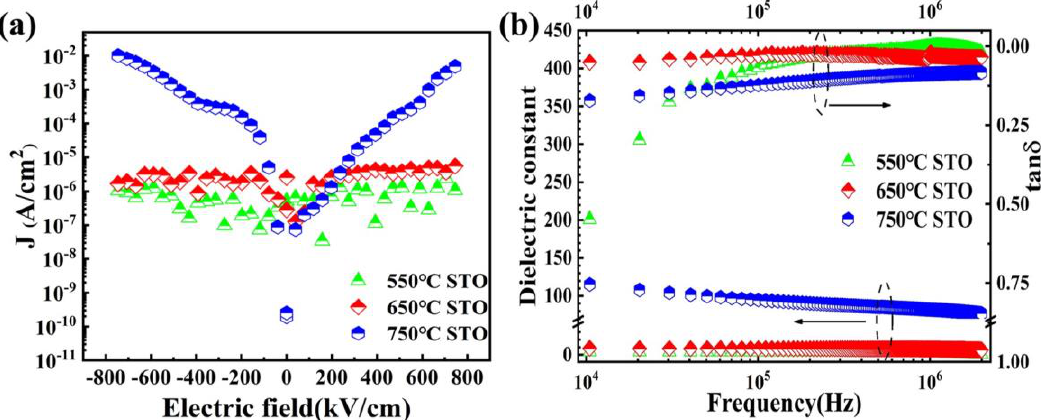
Figure 5. ( a ) Leakage current density vs. electric field ( J - E ) curves, ( b ) frequency-dependent dielectric behaviors of STO thin films annealed at different temperatures.